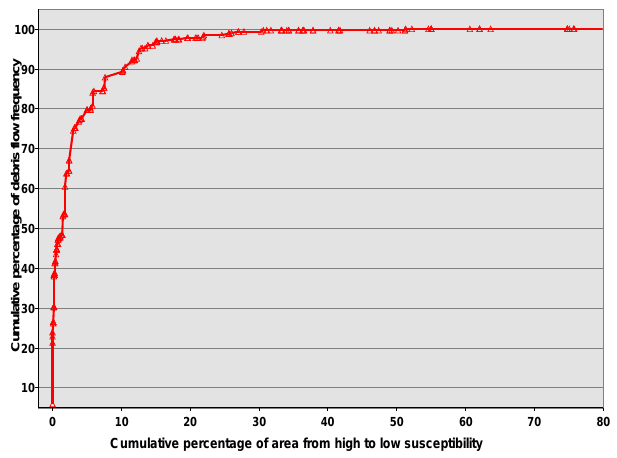
Figure 3. Prediction rate of qualitative heuristic debris flow sus- ceptibility map represents a good correlation between debris flow susceptibility and